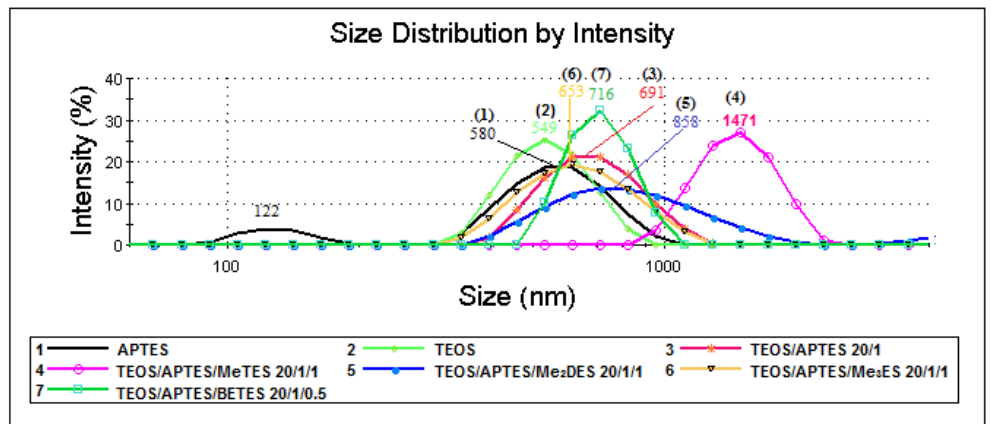
Figure 2. Size distribution by intensity of aminopropyl silica particles.